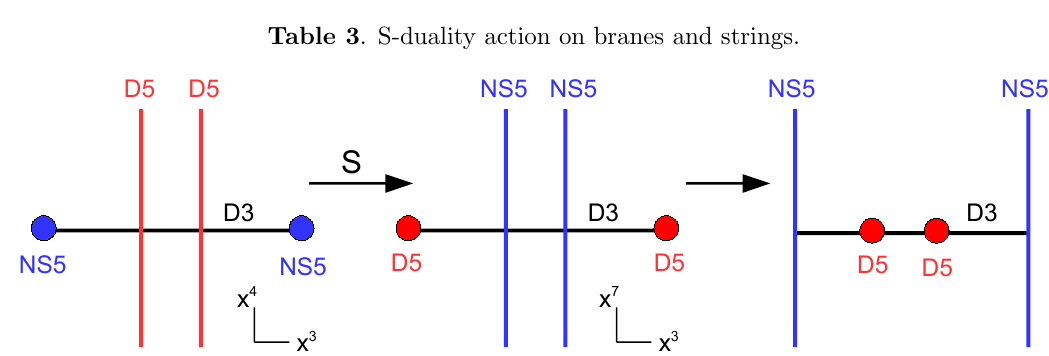
Figure 12 . Brane con(cid:12)guration of T [SU(2)]. After acting with the S transformation and moving the D5s to the middle, one recovers the initial